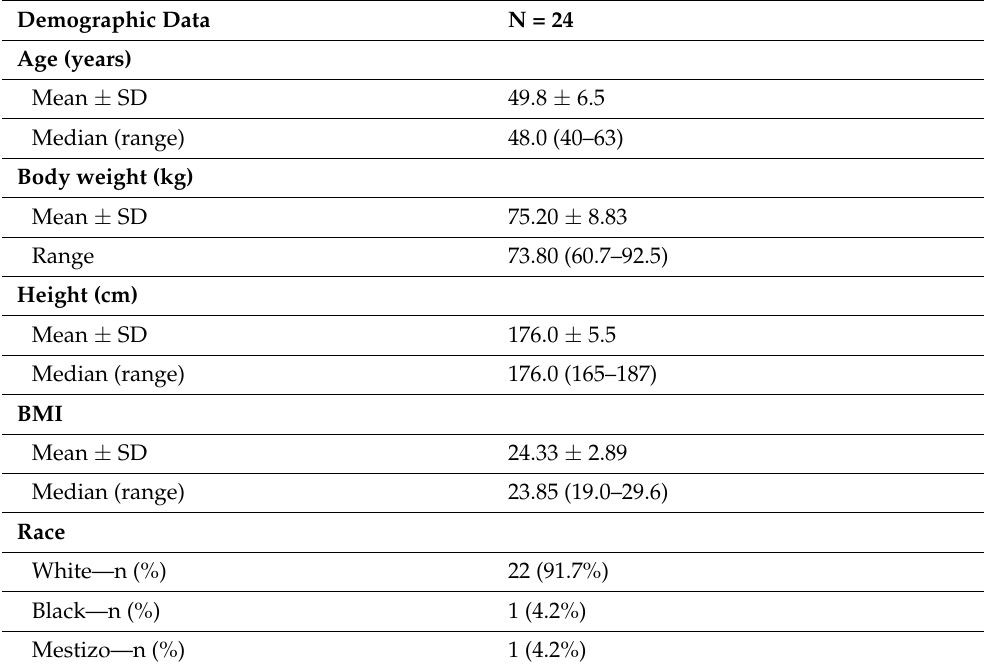
Table 1. Mean ( ± SD) baseline demographic data (N = 24). Demographic